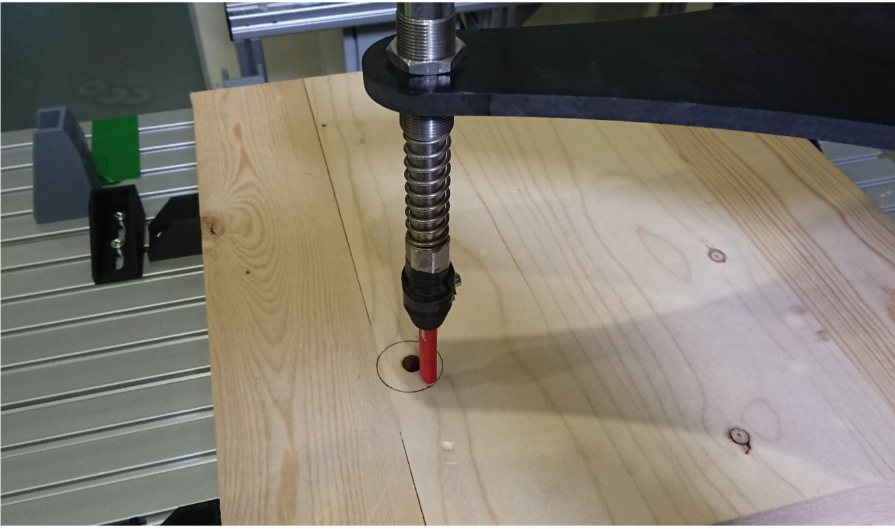
Figure 13. This figure shows the robot pen tool indicating a knot hole defect on the CLT panel by drawing a circle around